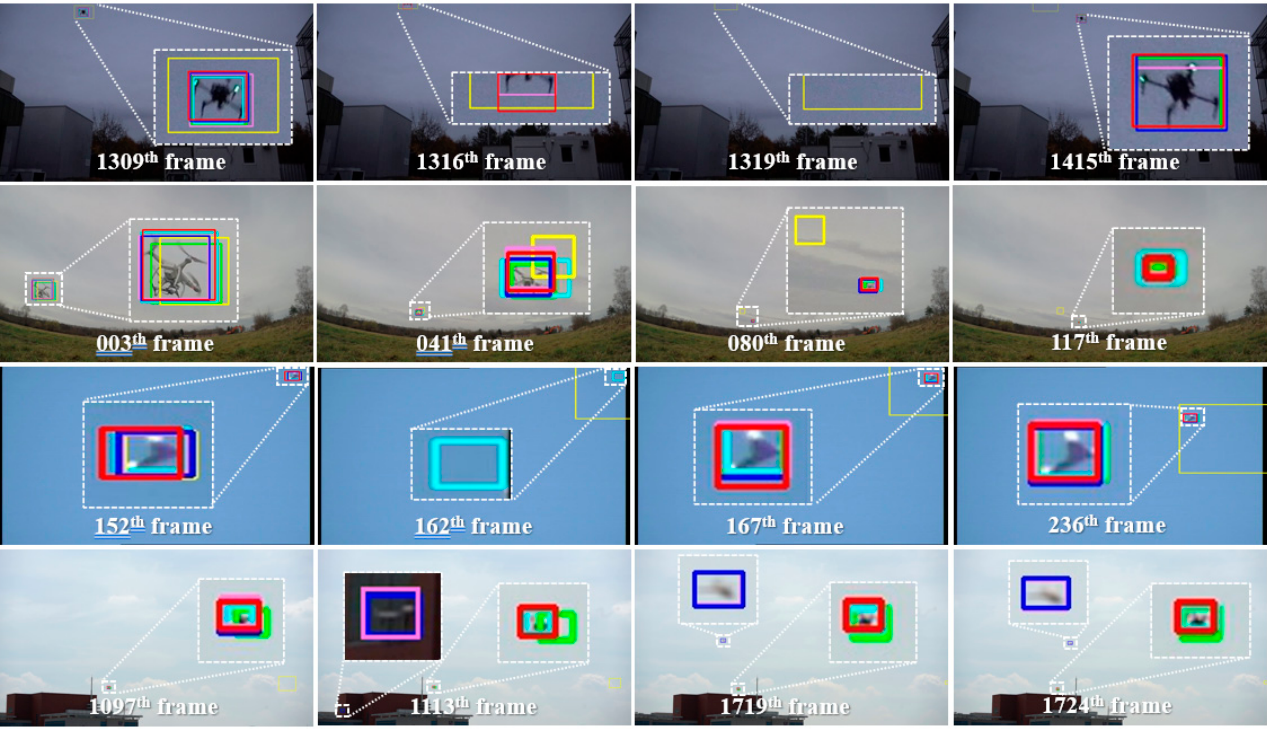
Figure 6. Visual results of the compared methods (from top to bottom) for Seq4, Seq5, Seq6, and Seq8. Red boxes represent the proposed method (MedianFlow and YOLOv4), green boxes represent the ground truth, yellow boxes represent MedianFlow [39], pink boxes represent YOLOv4 [20], light-blue boxes represent SiamRPN++ [30], and blue boxes represent the LC (MedianFlow, YOLOv4) method [5].